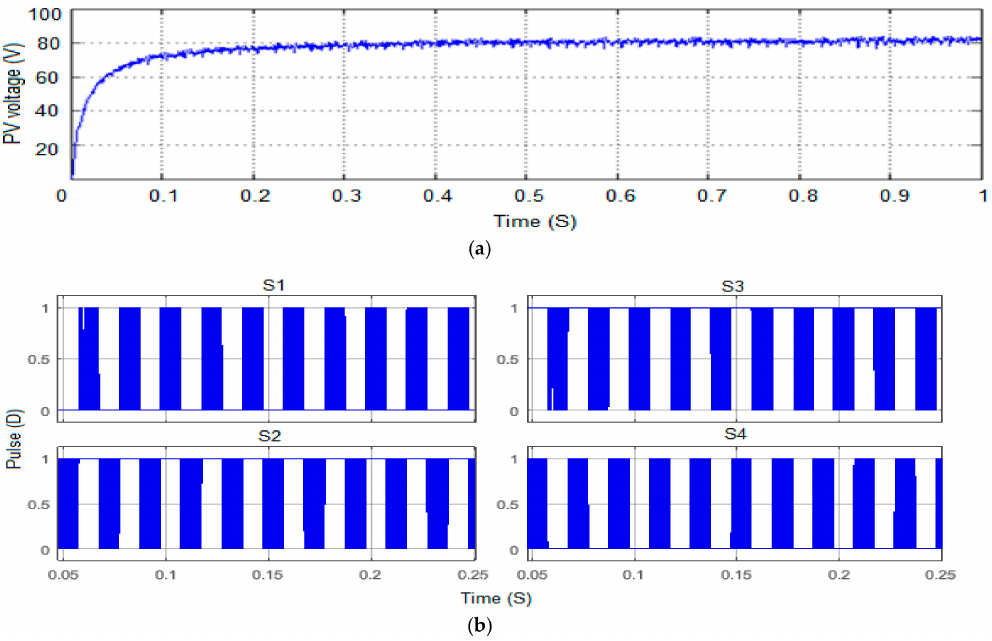
Figure 10a,b show the PV array voltage and switching pulses for leg-A of 3-level NPC inverter respectively. The comparison of various parameters like stepped inverter output voltage, output voltage with split inductor, capacitor voltage balancing and output current for various control methods like 2D-SVM, 3D-SVM and effectual 3D-SVM is shown in Figure 11. From the comparison, it is evident that the effectual 3D-SVM is better than other control schemes.